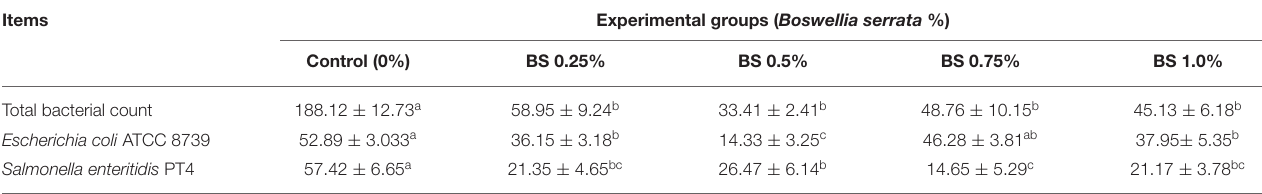
TABLE 6 | Effects of Boswellia serrata on cecal microbiota (total bacterial count, Escherichia coli , and Salmonella enteritidis ) in NZW growing rabbits.